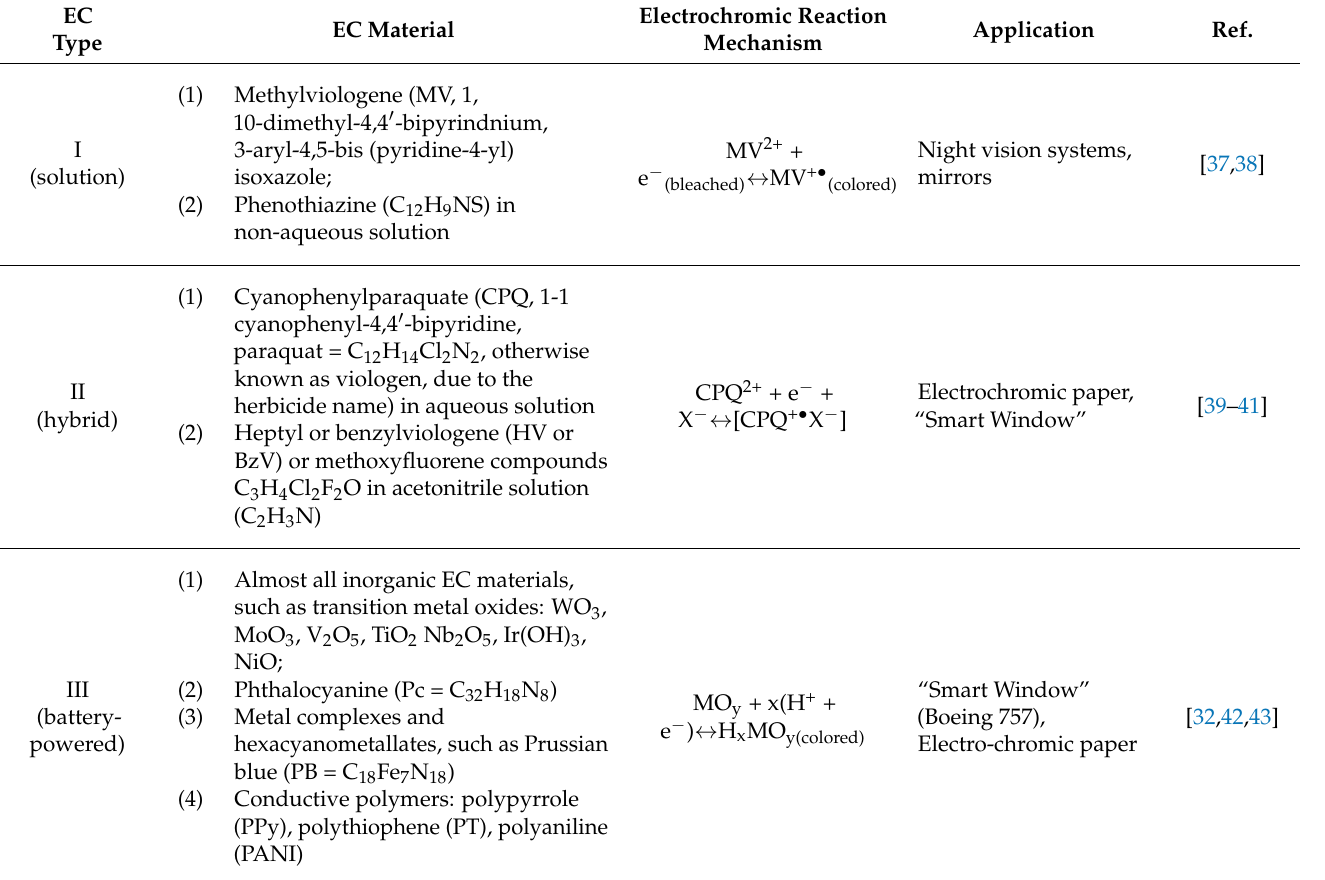
Table 3 contains examples of each type of EC. Table 3. Classification of EC materials (according to I. F. Chang Table 3. Classification of EC materials (according to I. F. Chang [36]).